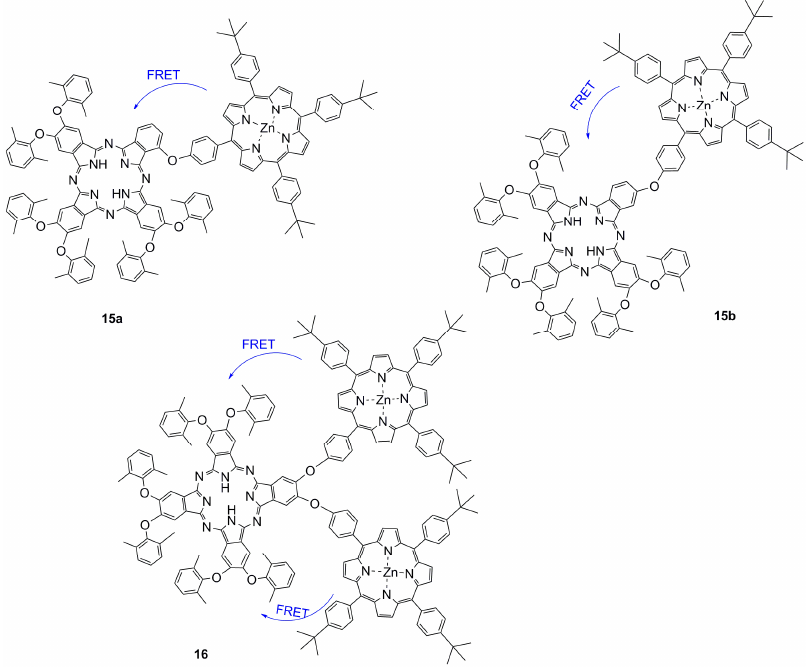
Figure 5. Schematic of phthalocyanine − porphyrin heterodyads for the detection of Pb 2+ ion by fluorescence resonance energy transfer (FRET). Reproduced from ref [38,40,41].